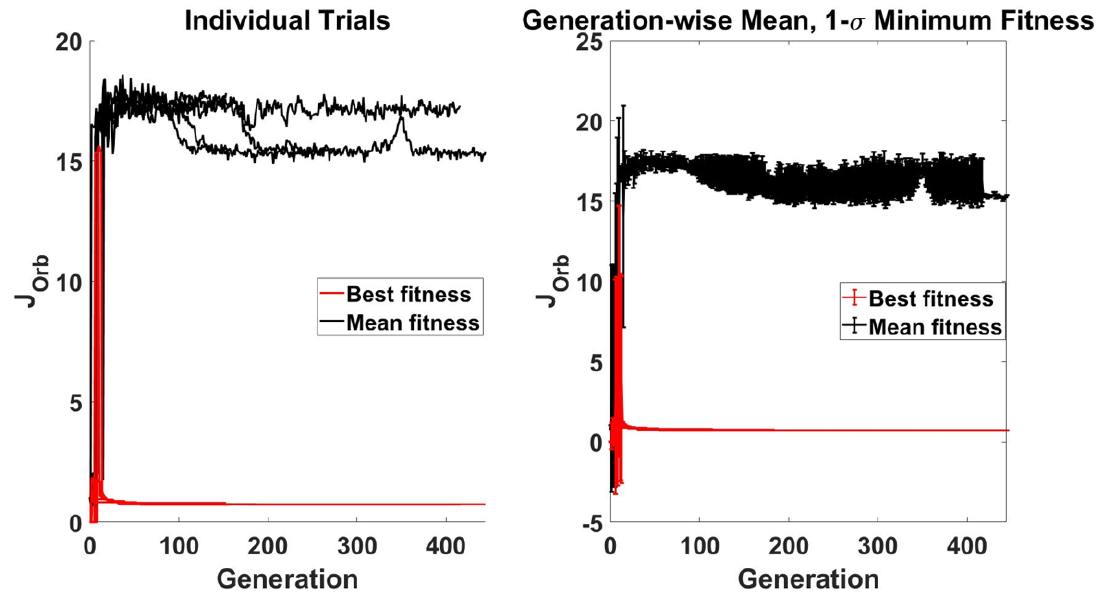
Figure 15. Variation of the co-orbital design fitness for the Perseus mission concept across different GA populations generations showing: the individual optimization trials ( left ); and their statistical distribution ( right ).